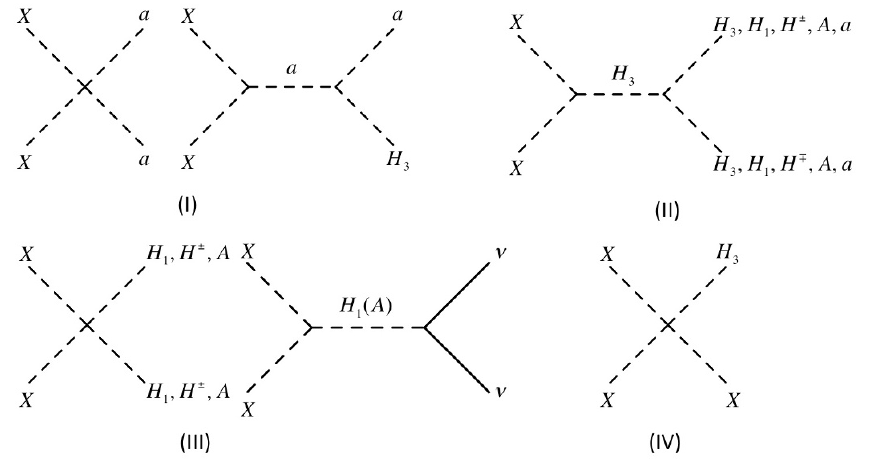
Figure 1 . Diagrams in (I), (II), (III) and (IV) correspond to DM annihilation process in scenario-I, II, III and